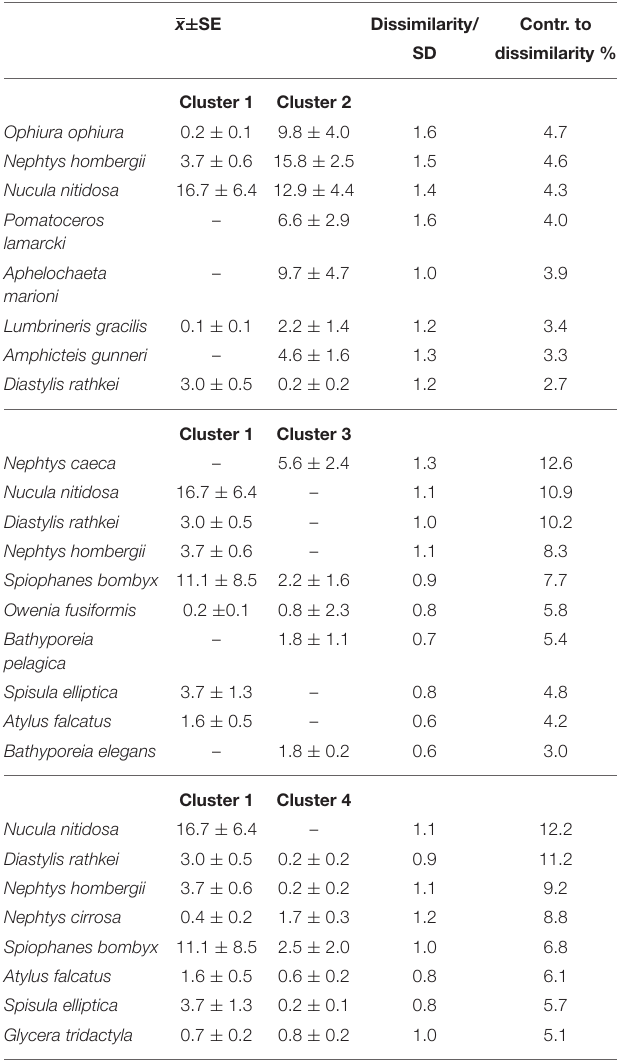
TABLE 2 | Discriminating species between the main groups of samples of the 2014 benthos survey in Swansea Bay (SIMPER). x ± SE Dissimilarity/ Contr. to